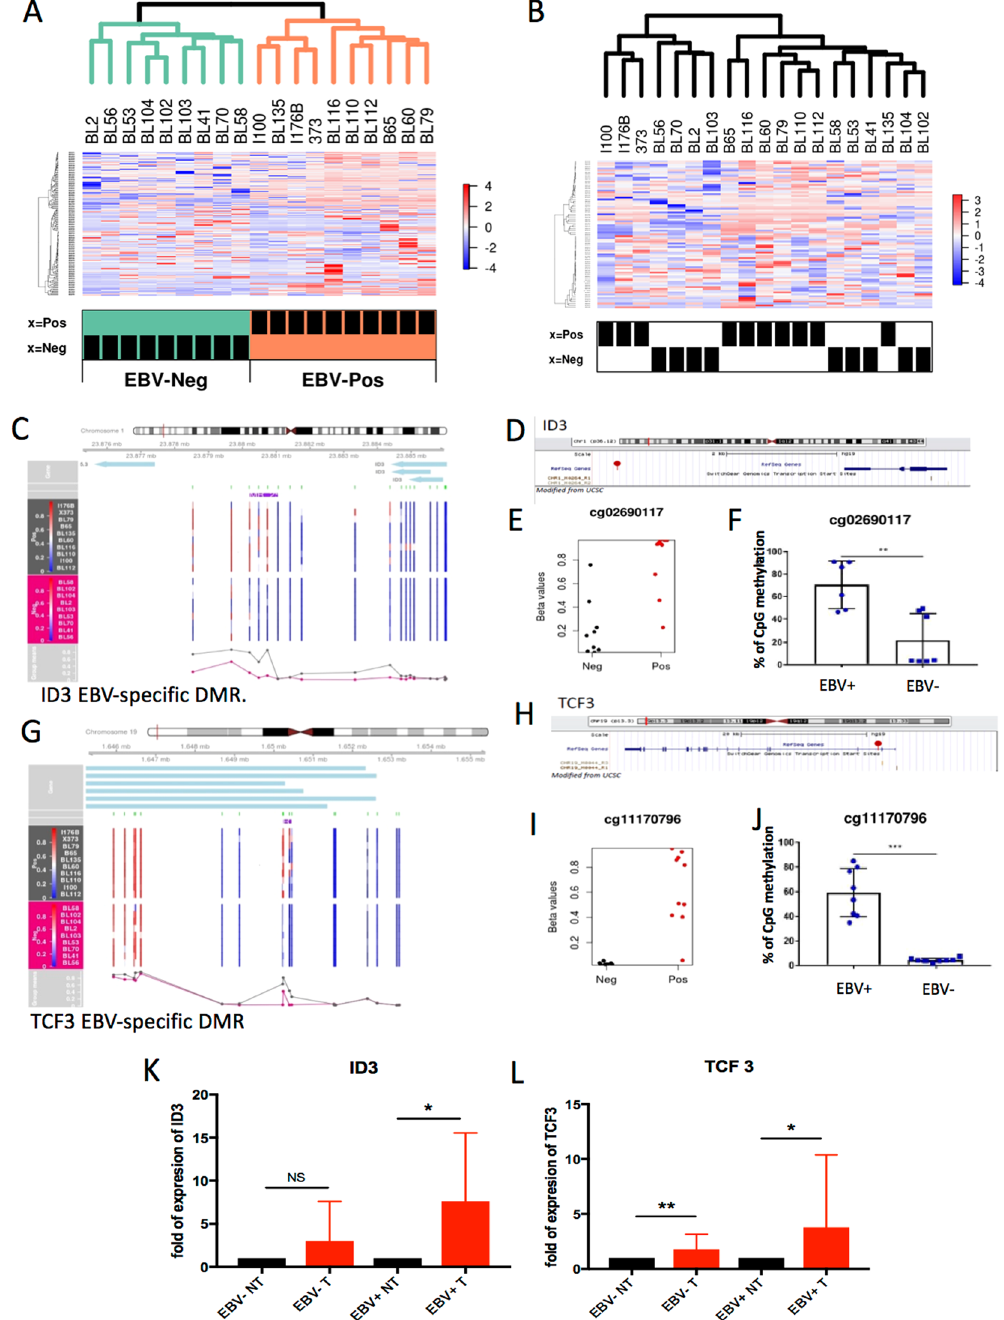
Figure 4. Unsupervised clustering of sBL or eBL mutational signatures in EBV ( + ) and EBV ( − ) BL. Methylation of sBL drivers in EBV ( + ) and EBV ( − ) BL cell lines ( A ). Methylation of eBL drivers in EBV ( + ) and EBV ( − ) BL cell lines ( B ). ( C and G ) DMR plot corresponding to ID3 and TCF3 regions. ( D and H ) Schematic representation of ID3 promoter, red dots identify cpg of interest (adapted from UGC web site). ( E and I ) strip-chart plots showing differential methylation in EBV pos and EBV neg BLs at position cg02978140 ( E ) and cg11170796 ( I ), on ID3 and TCF3 promoters respectively. ( F and J ) The histograms show the average % of methylation of cg02978140 ( F ) and cg11170796 ( J ) in the DNA of 7 EBV ( + ) and 7 EBV ( − ) BLs, measured by pyrosequencing ( ** p value < 0.01, *** p value < 0.001). ( K and L ) Three EBV ( + ) and 3 EBV ( − ) BL cell lines were cultured in presence of 5-Aza-2 ′ -deoxycytidine at the final concentration of 10 μ M for 48 h (T = treated) or with DMSO (NT = untreated). mRNA levels of ID3 and TCF3 were analyzed by qPCR. The pooled results of three independent Aza treatment are represented in the histograms ( * p value < 0.05, ** p value < 0.01, ns =